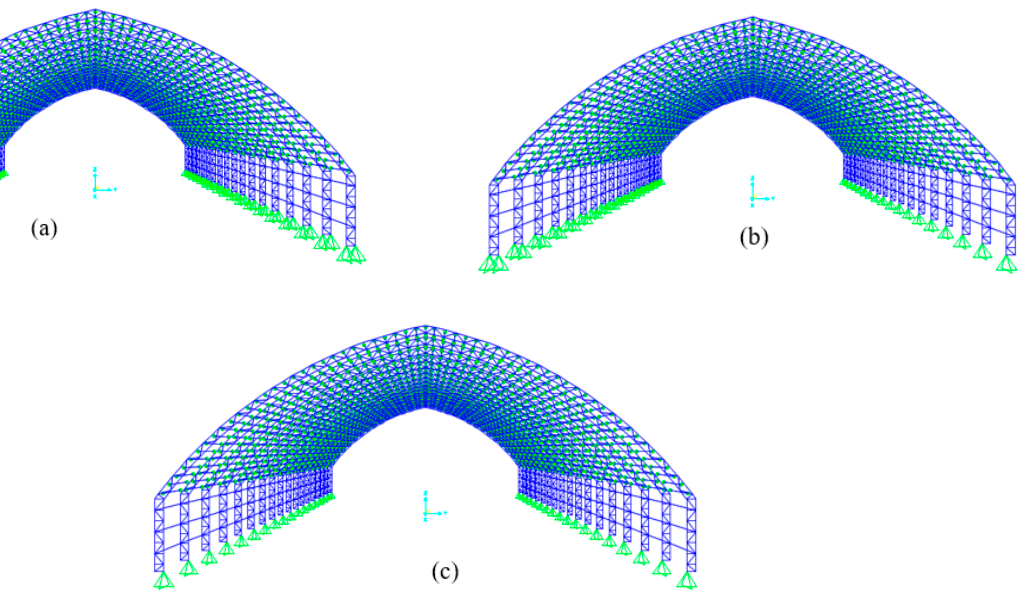
Figure 9. Boundary conditions of Model 1: ( a ) four supports; ( b ) three supports; ( c ) two supports.